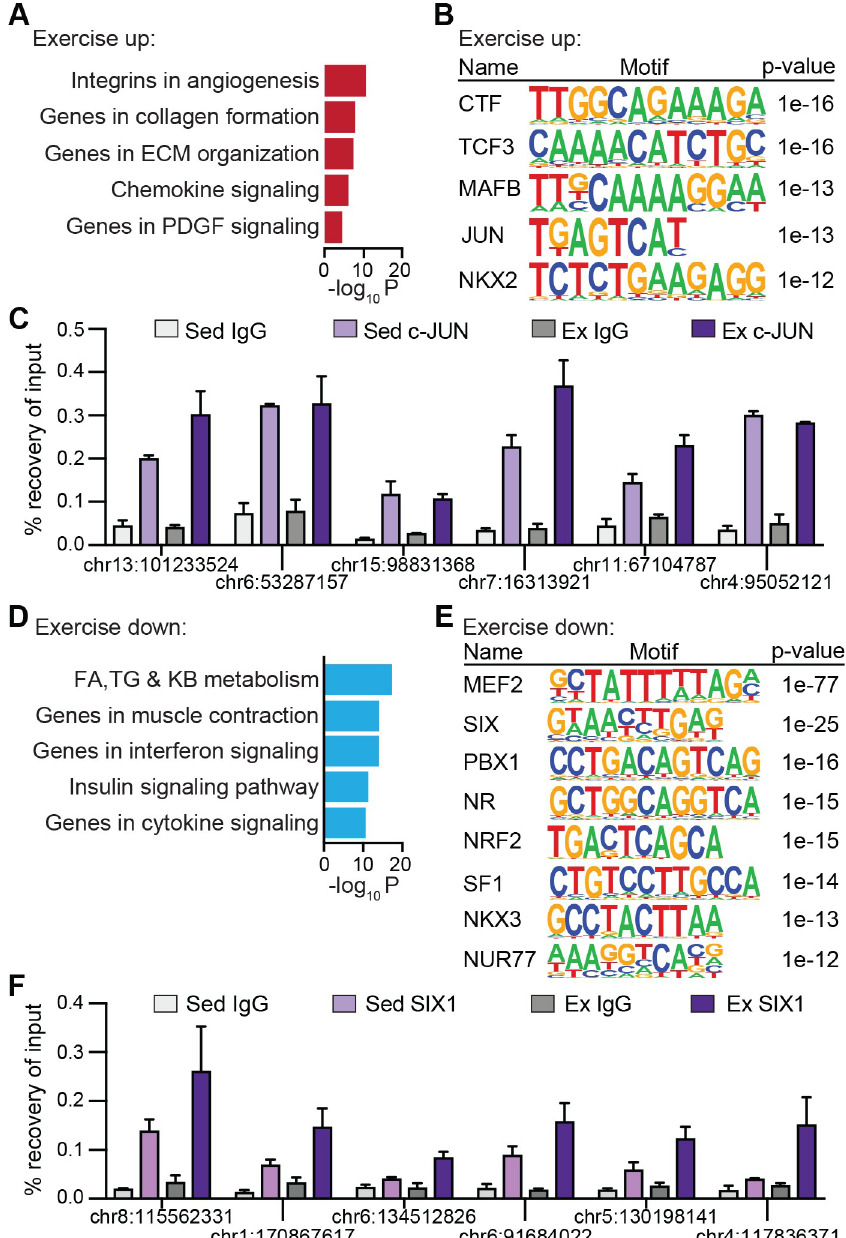
Fig 7. Motif predictions and validations at EMRs. (A) Top ontologies for genes annotated near hyperacetylated H3K27ac regions in Ex Quad. (B) Motifs enriched at hyperacetylated EMRs. (C) ChIP qPCR validation of c-JUN binding in Sed and Ex Quad. Enrichment is plotted as percent of input using technical duplicate control IgG and c- JUN ChIPs. (D) Top ontologies for genes annotated near hypoacetylated H3K27ac regions in Ex Quad. (E) Motifs enriched at hypoacetylated EMRs. (F) ChIP qPCR validation of SIX1 binding in Sed and Ex Quad. Enrichment is plotted as percent of input using technical duplicate control IgG and SIX1 ChIPs. Numerical values for all panels are available in S1 Data. CTF, CCAAT box-binding transcription factor; ChIP, chromatin immunoprecipitation; chr, chromosome; EMR, exercise-modified region; Ex, exercised; ECM, extracellular matrix; FA, fatty acid; H3K27ac, histone 3 lysine 27 acetylation; IgG, immunoglobulin G; Jun, jun proto-oncogene; KB, ketone body; MAFB, MAF bZIP transcription factor B; NKX2, NK2 homeobox; NUR77, nuclear hormone receptor 77; NR, nuclear receptor; PBX1, pre-B-cell leukemia homeobox 1; PDGF, platelet-derived growth factor; qPCR, quantitative PCR; Quad, quadriceps femoris; Sed, sedentary; SIX, sine oculis homeobox factor; SF1 steroidogenic factor 1; TCF3, transcription factor 3; TG,